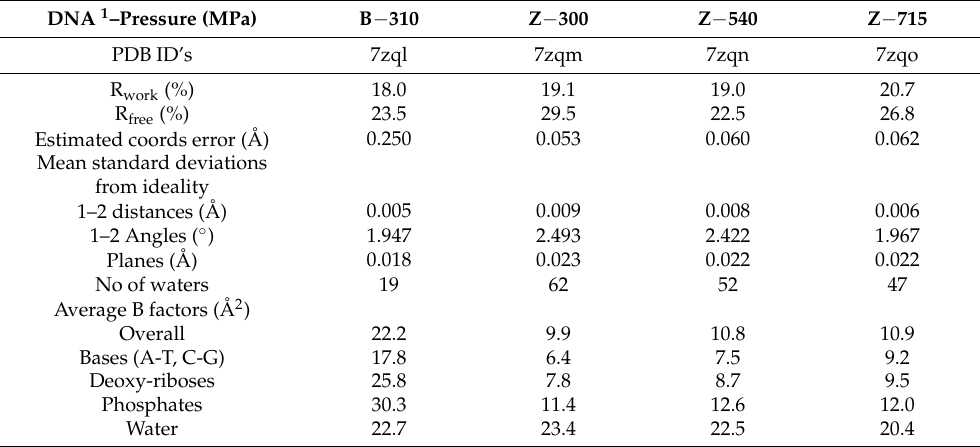
Table 2. Summary of refinements